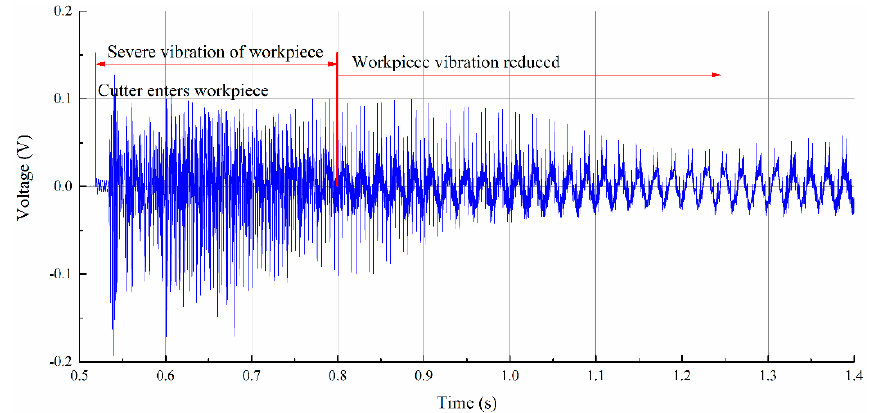
Figure 8. Transition from the vibration stage to the stable cutting stage.